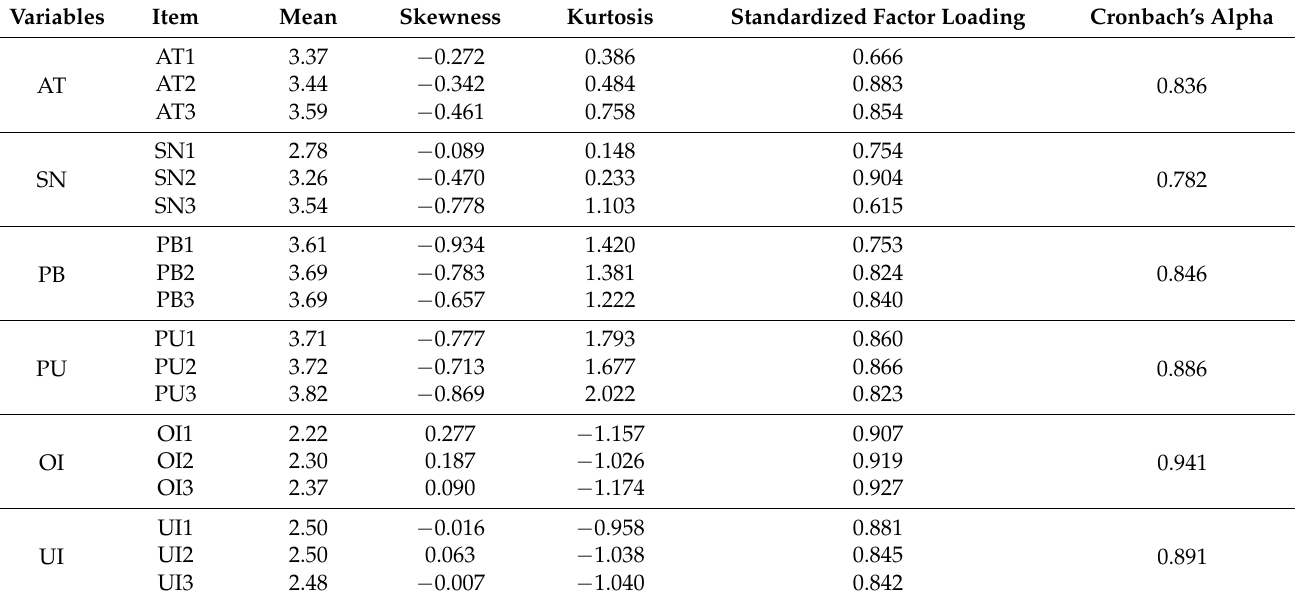
Table 1. Description statistics and normality